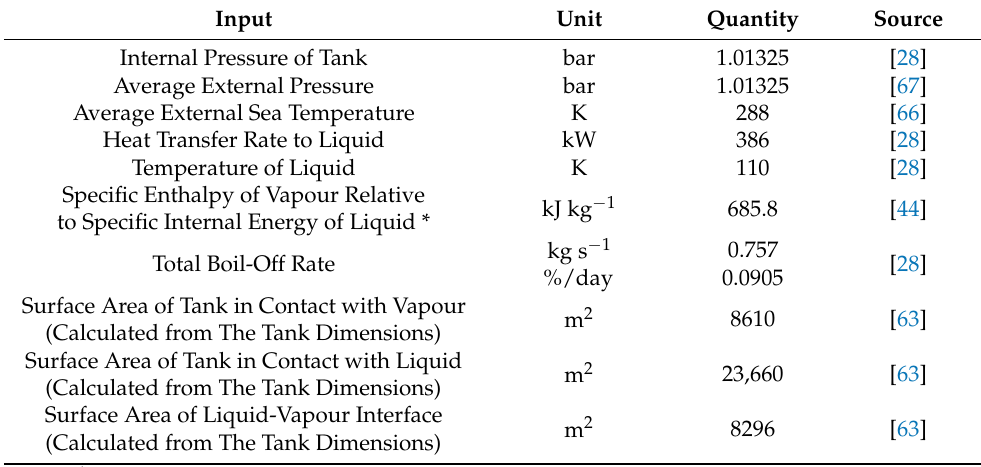
Table 4. Thermodynamic data for the conventional LNG ship [28,44,63,66,67].